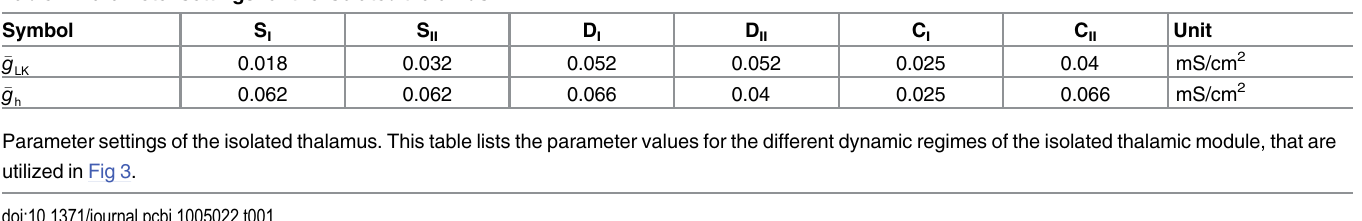
Activation of I is responsible for a refractory period that follows a spindle. As long as I h h activation persists, LTS generation is impeded and stronger perturbations are necessary to trig- ger spindle oscillations. Consequently, an increase in (cid:2) g results in a larger inter-spindle inter- h ) is encased by the Hopf and the torus bifurcation, whereas the val. The left spindle regime (S I ) is constrained by two global bifurcations that are indicated by the right spindle regime (S II dashed gray lines. The vertical line marks the emergence of the torus bifurcation, whereas the horizontal gray line marks the cusp bifurcation where the two saddle-nodes that accompany the left torus bifurcation vanish. the model transitions from high frequency spindle Furthermore, for larger values of (cid:2) g LK oscillations to low frequency delta oscillations, e.g. Fig 3-D and 3-D . I II